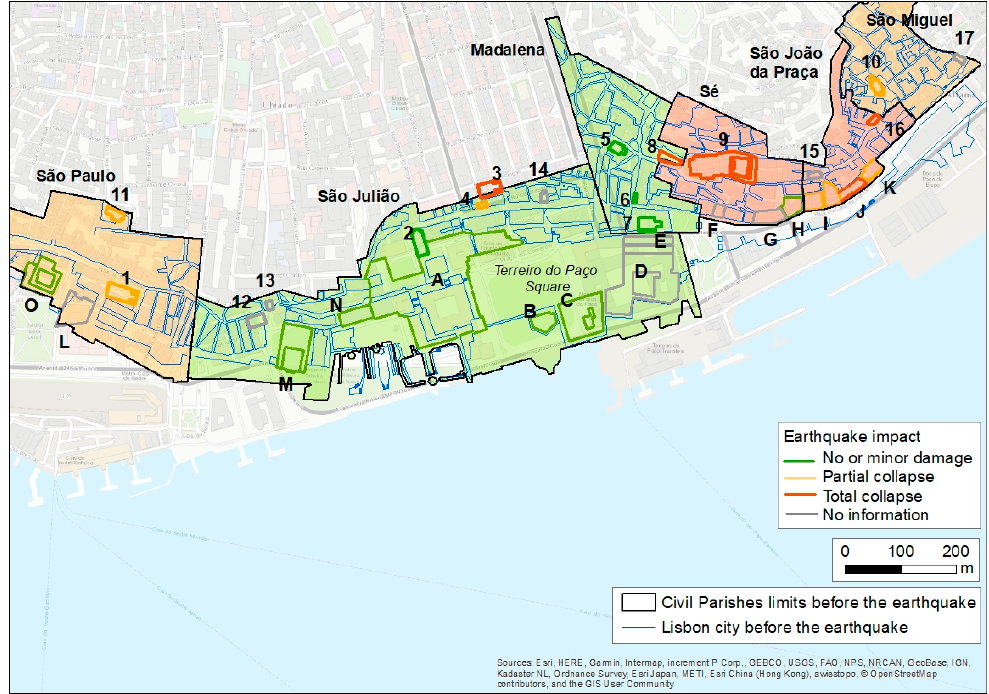
Figure 10. Damage classification caused by the earthquake on churches, other buildings and the